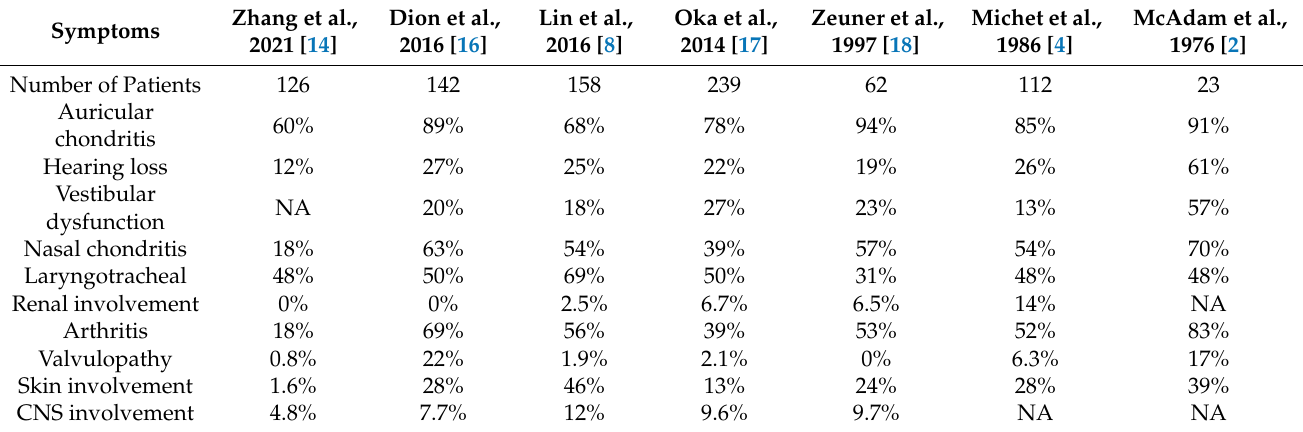
Table 6. Incidence of major systemic manifestations of RPC in large case